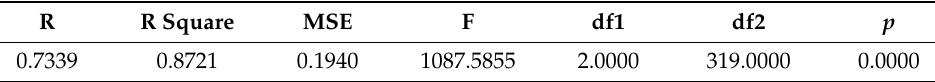
Table 8. Coefficients of Regression (path-b and ć ).